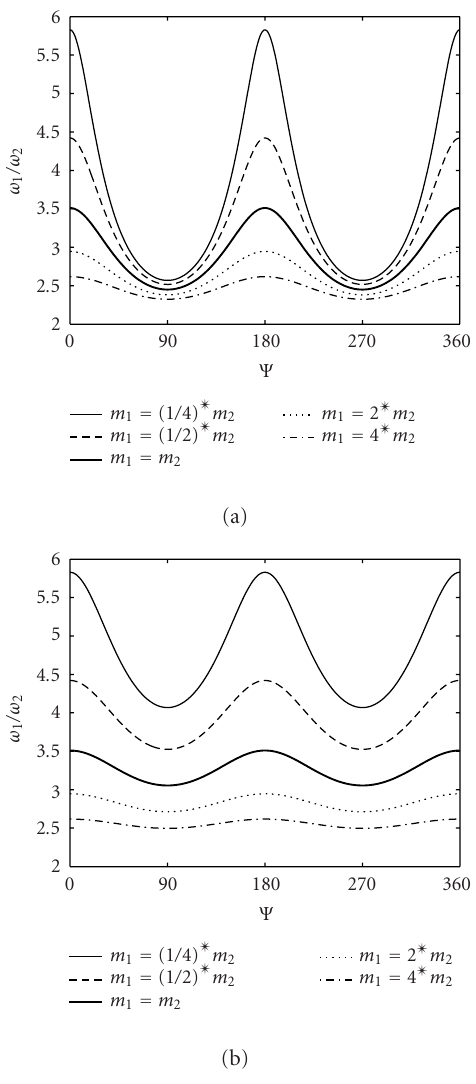
Figure 4.6. The ratio of frequencies versus angle between the oscillation planes for point masses ratio and small length of second pendulum. The initial parameters for (a) L 2 = 0 . 2 m, L 1 = 5 · L 2 , m 2 = 2kg; and for (b) L 2 = 1m, L 1 = 5 · L 2 , m 2 = 2